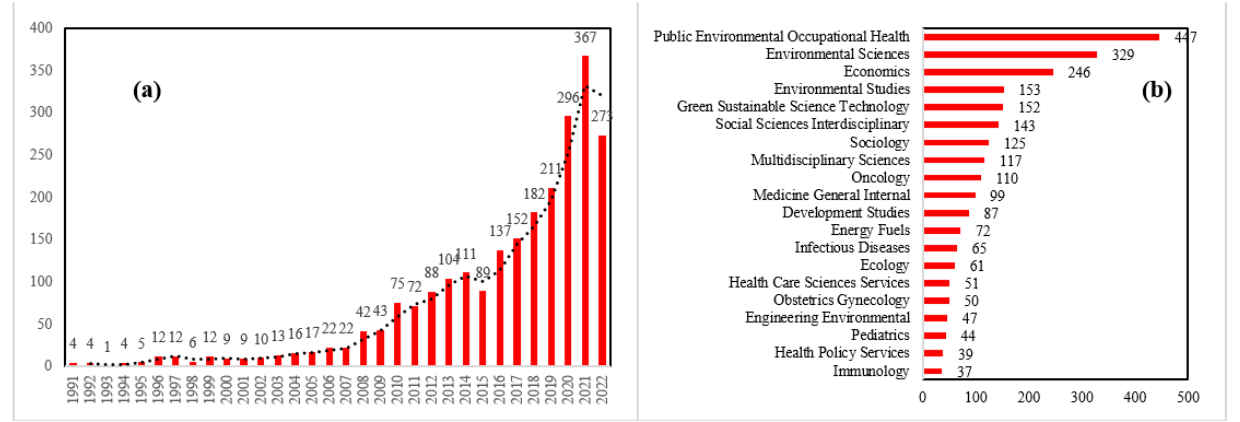
Figure 1. Total number ( a ) and fi eld distribution ( b ) of papers on human development index.